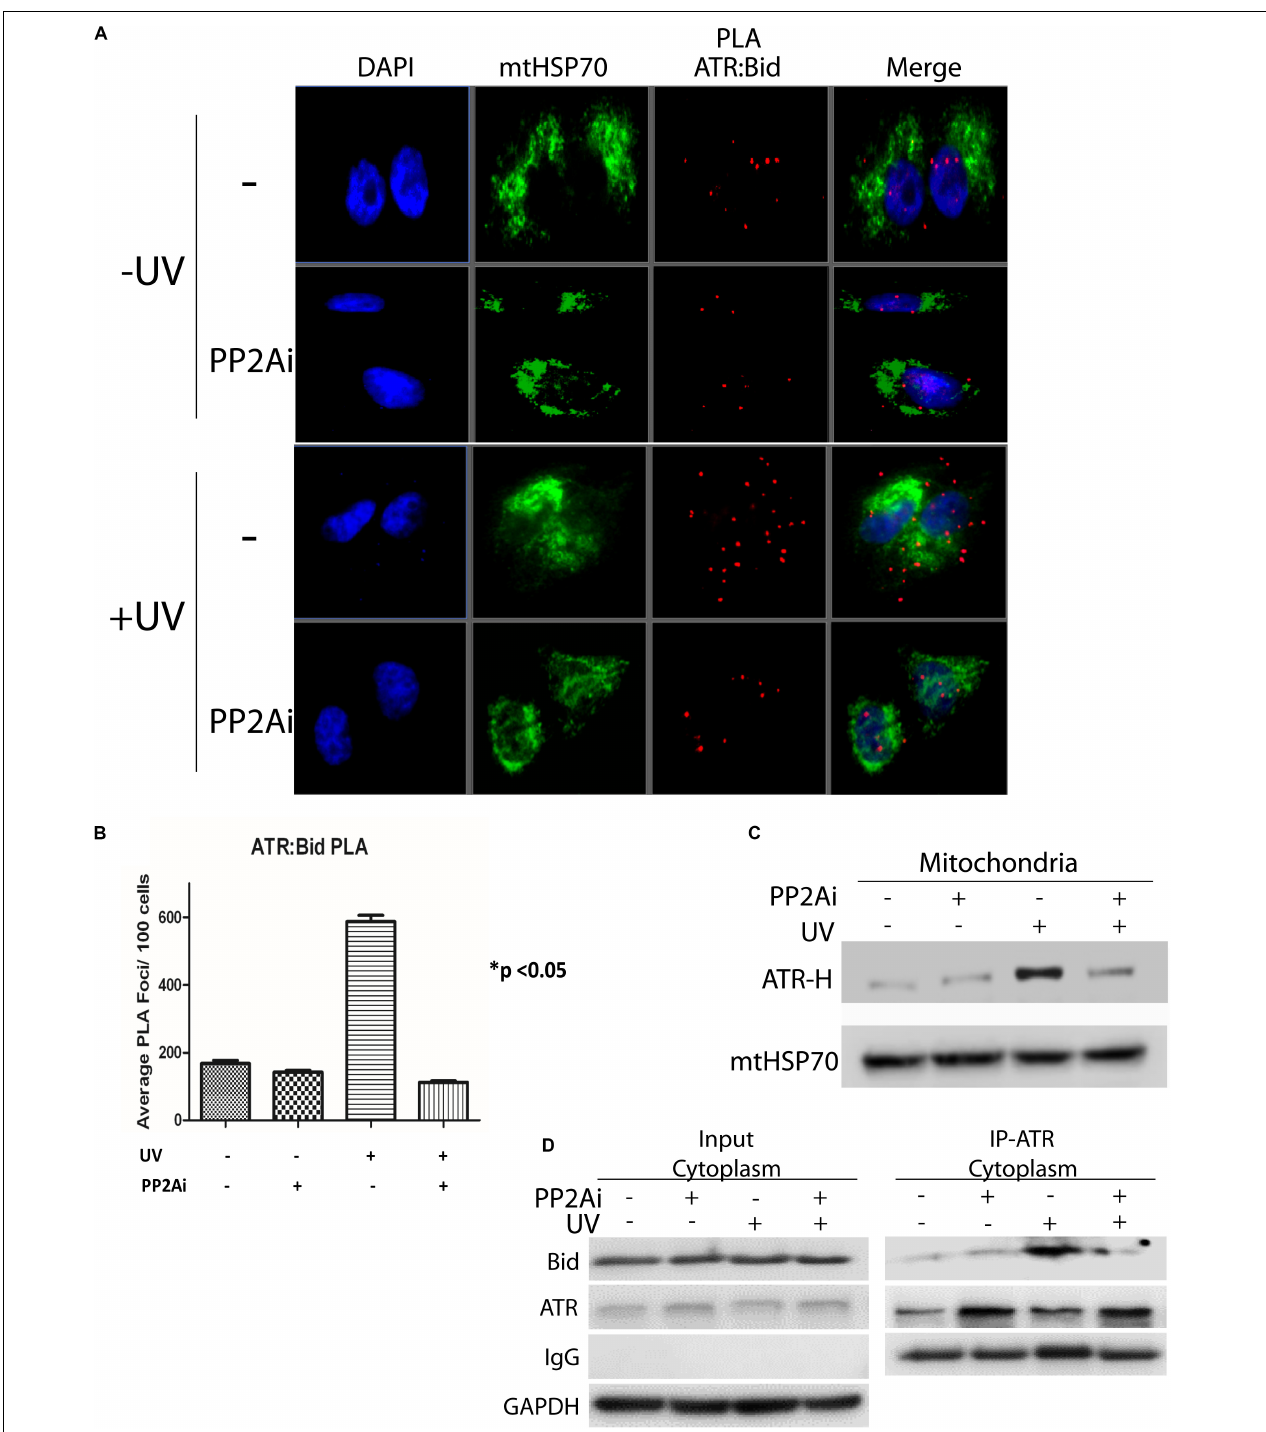
FIGURE 4 | Inhibition of PP2A’s dephosphorylation of pATR and ATR-L accumulation in the cytoplasm leads to reduced association of ATR with tBid on mitochondria. (A) PLA shows that cytoplasmic ATR directly associates with Bid and that this association increases with UV treatment, but the UV-induced association is attenuated by PP2A inhibitor treatment. The nuclei are stained with DAPI and mitochondria are indicated by mtHSP70 immunofluorescence. A549 cells were UV irradiated at 40 J/m 2 with a 2 h recovery. (B) A graphic display of the PLA data shown in (A) . The p < 0.05 refers to the sample (+UV, − PP2Ai) versus any of other samples. (C) ATR-H accumulation at the mitochondria increases with UV treatment at 40 J/m 2 in A549 cells, but is reduced in cells treated with PP2A inhibitor. (D) Biochemical confirmation of the reduction in the cytoplasmic ATR:tBid association observed by PLA (A,B) . A549 cells were pretreated with PP2Ai followed by UV irradiation with a 2 h recovery. After cellular fractionation ATR was immunoprecipitated from the cytoplasmic fraction using C-terminal-specific ATR antibody. The association of tBid with ATR was confirmed by WB.